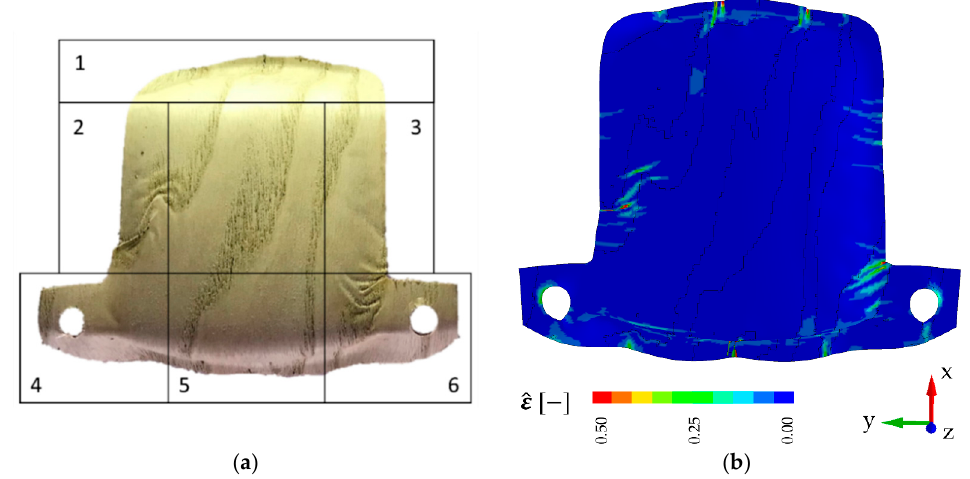
Figure 9. Forming results of sample 𝟏 ∥ . ( a ) Experiment; ( b ) simulation with output of equivalent strain.